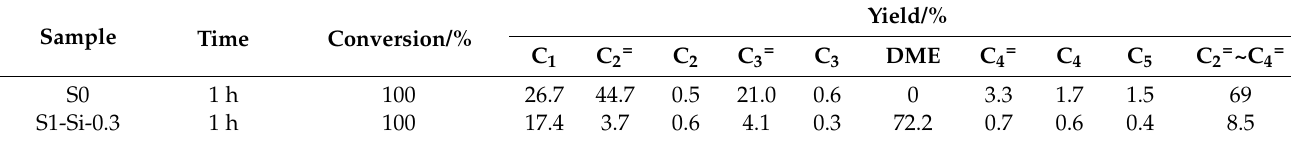
Table 1. Results of MTO catalytic